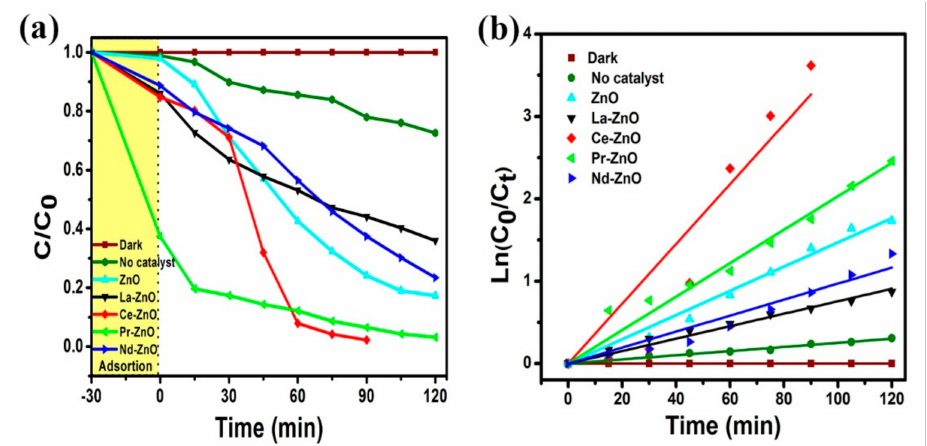
Figure 9. ( a ) The degree of degradation of the RhB dye in each time interval; ( b ) a graph of the kinetics of the degradation of the RhB dye, plotted for the first linear order as Ln(C 0 /C t ) vs. irradiation time (t). Data are given for nanoparticles calcined to 500 ◦ C.